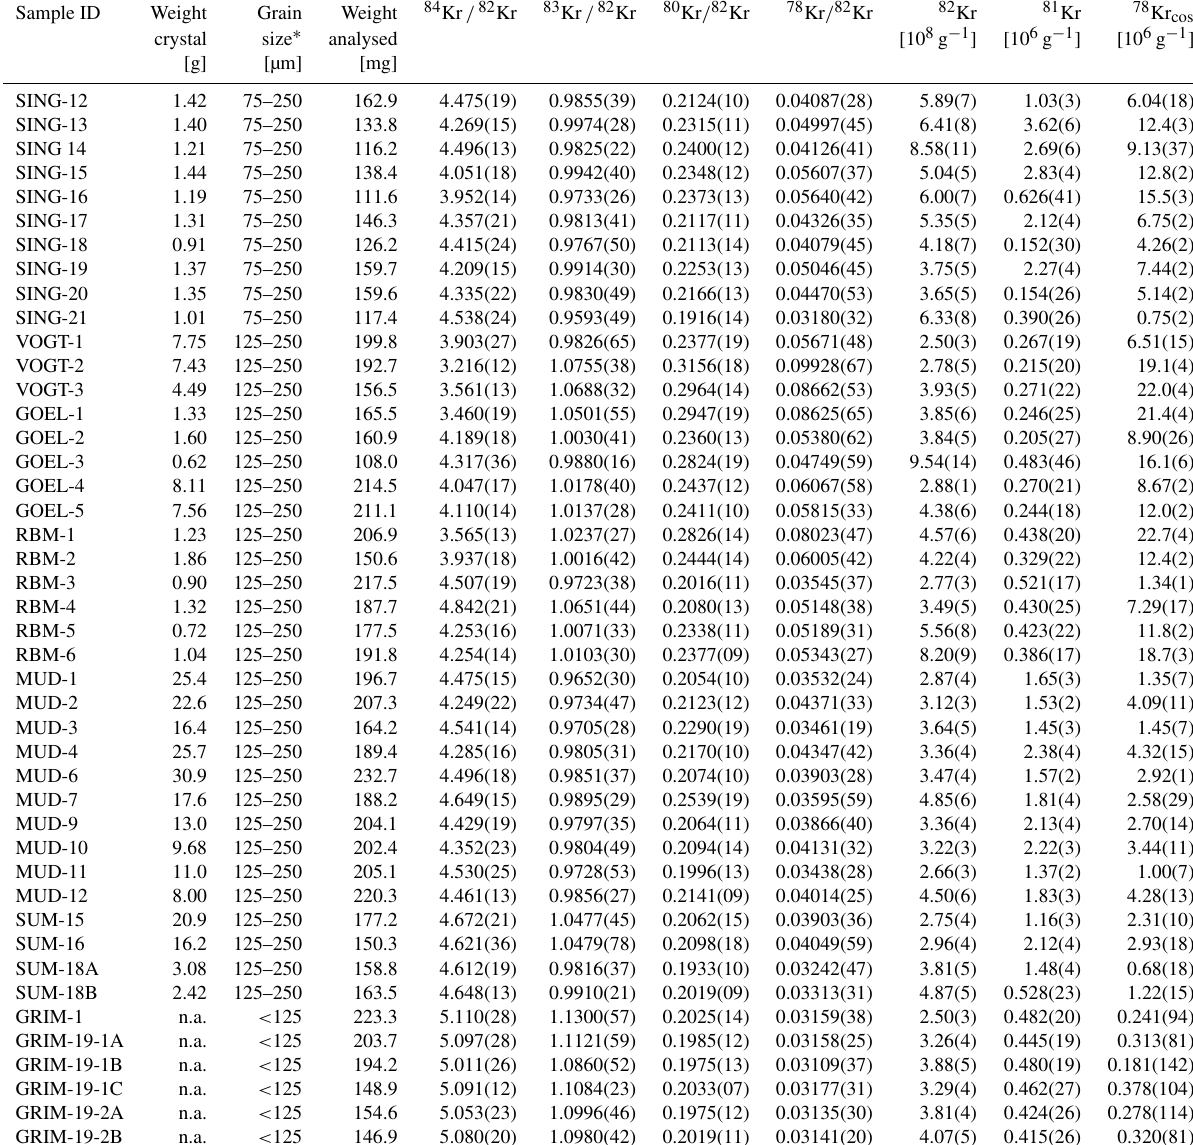
78 Kr / 82 Kr ratio (Aregbe et al., 1996); n.a.: not